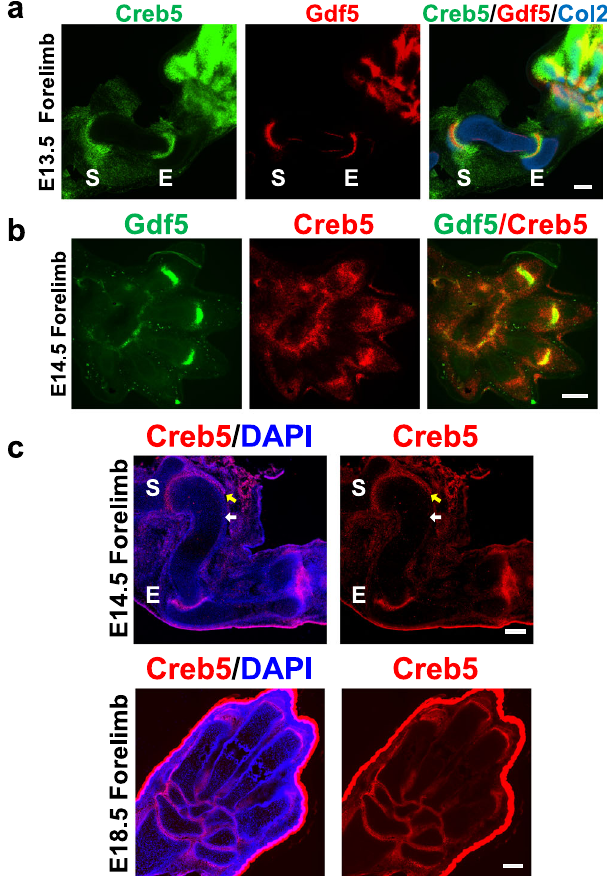
Fig. 1 | Creb5 and Gdf5 expression overlap in the developing synovial joint interzones. a , b Gene expression in E13.5 and E14.5 forelimbs from WT mice assayedbymultiplexedRNAscopeFISH. c Immuno fl uorescentstainingofE14.5and E18.5forelimbsfromWTmiceforCreb5andDAPI(tovisualizenuclei).Thearticular perichondrium(yellowarrows)andmetaphyseal/diaphysealperichondrium(white arrows) are indicated. Shoulder (S) and Elbow (E) indicated. Similar results were obtained in at least two independent biological repeats. Scale bar equals 200